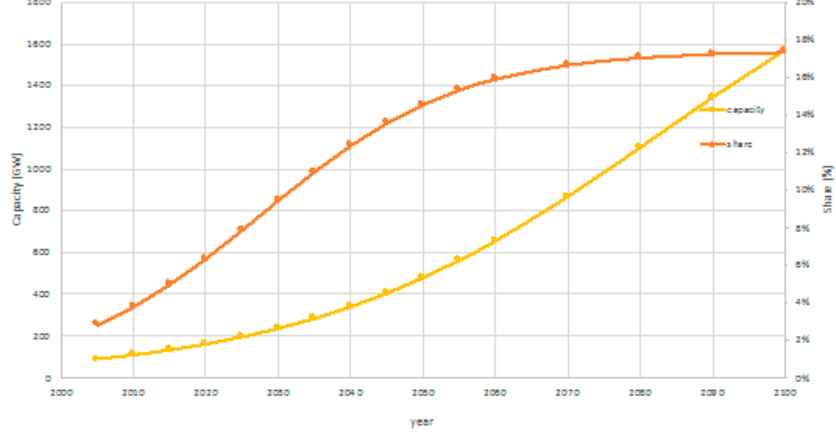
Figure 4. Europe PV technology capacity development based on the reference scenario of WITCH until the year 2100 (own work).